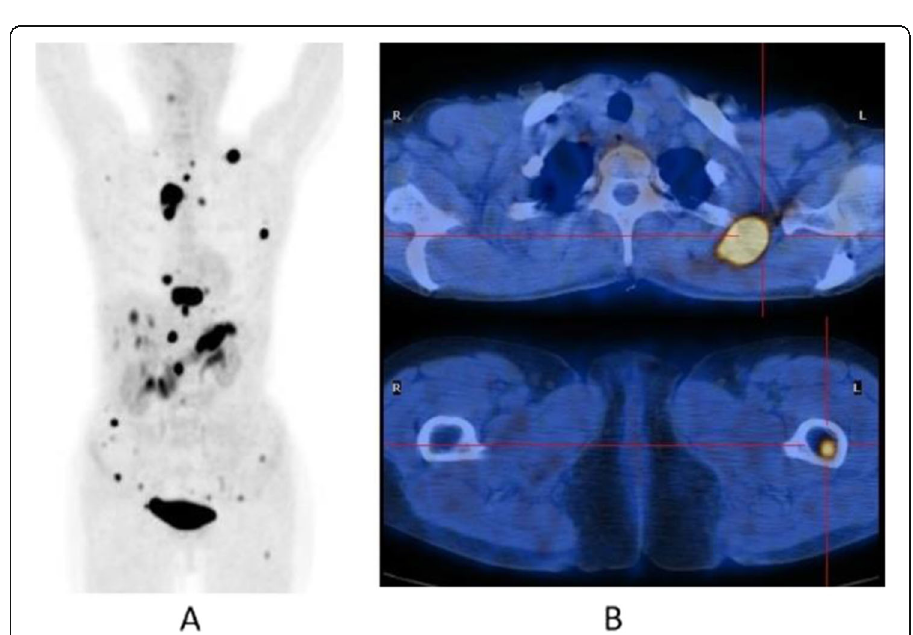
Fig. 43 18 F-FDOPA, carcinoid. Clinical history : 45 y.o. man with suspected right lung carcinoid. PET/CT findings : intense tracer uptake in the right lung and in multiple bone and soft tissue lesions seen on MIP ( a ) and fused images ( b